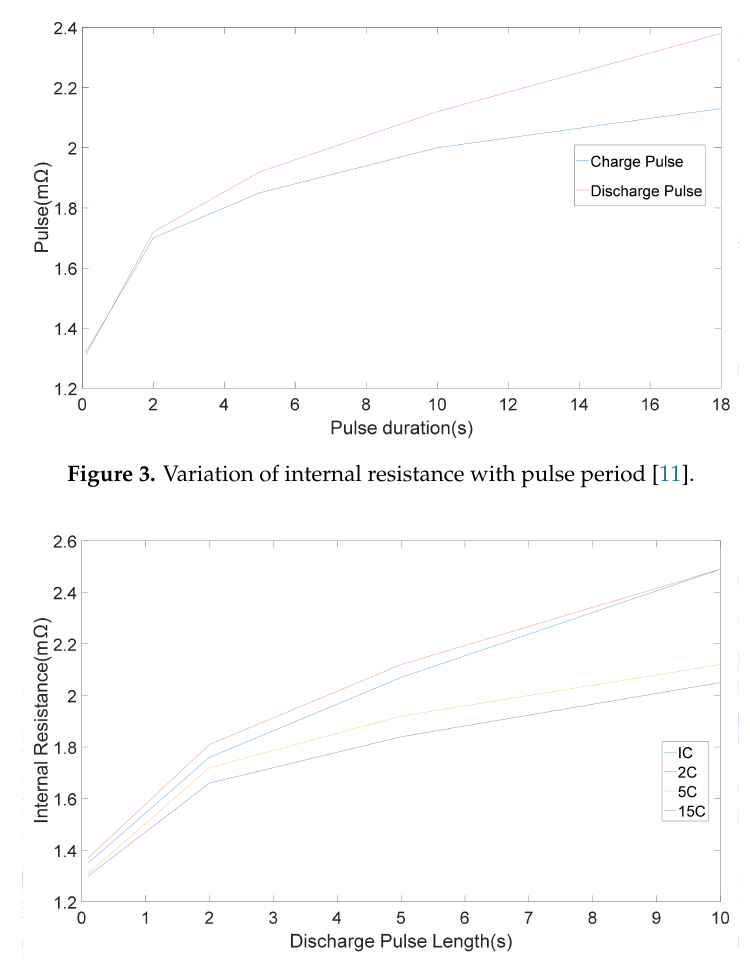
Figure 4. Internal resistance (m Ω ) computed from various amplitude discharge pulses [11].